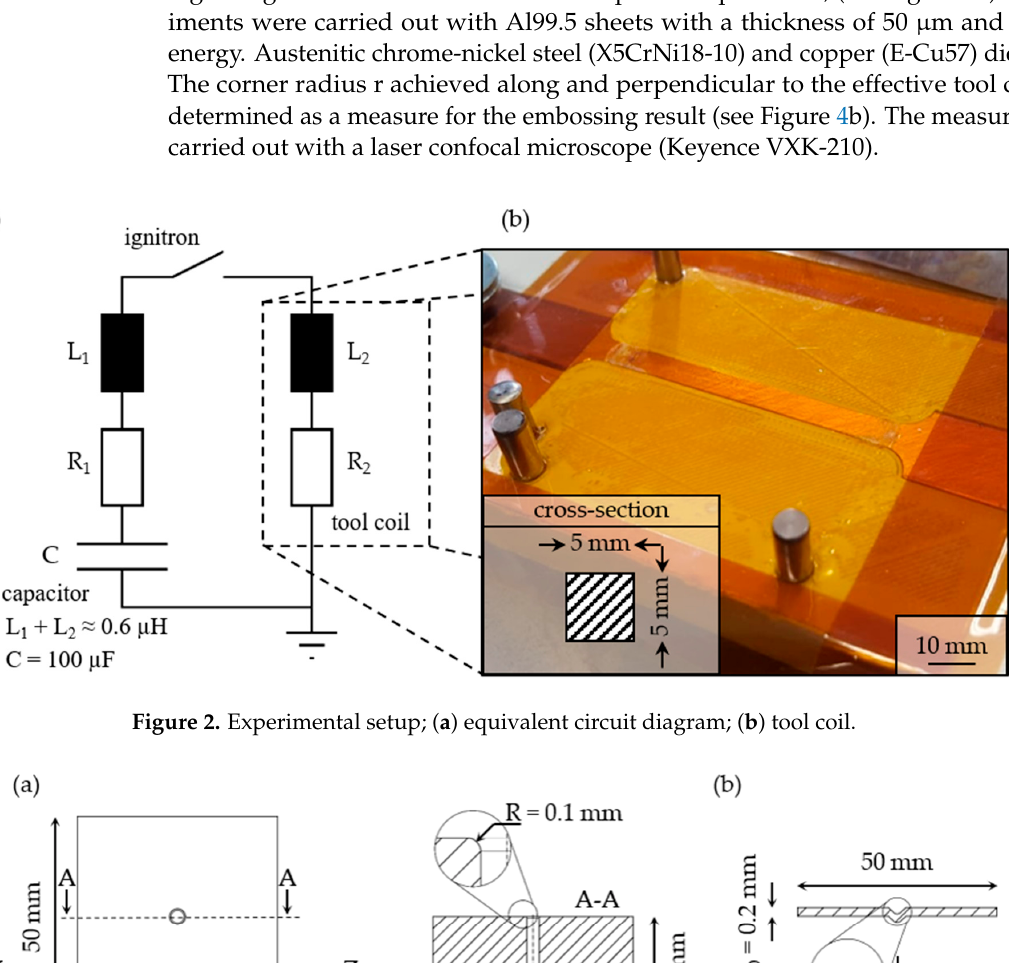
Figure 3. Forming experiment; ( a ) free forming die geometry; ( b ) resulting workpiece geometry.